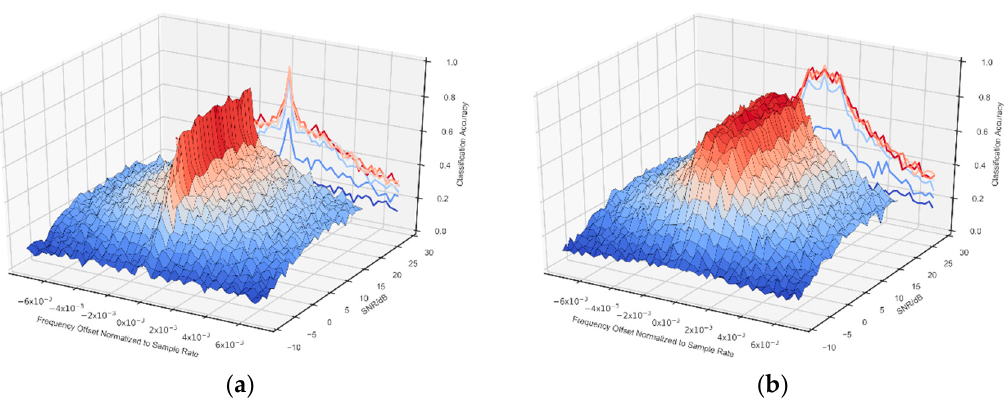
Figure 4. Overall classification accuracy of baseline classifier for various training scenarios vs. frequency offset and SNR. ( a ) CFO1; ( b )